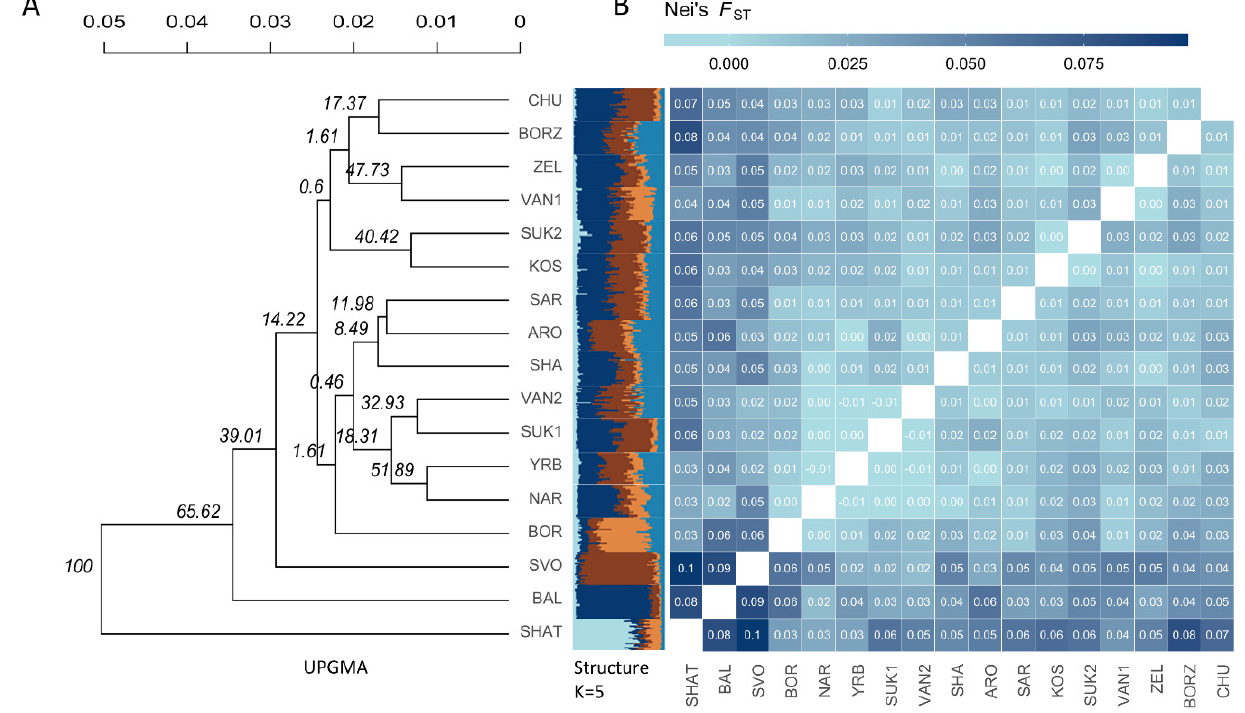
Figure 3. Bootstrapped UPGMA dendrogram ( A ), cluster assignments at K = 5, and the heatmap of pairwise of F ST between the 17 Scots pine populations investigated ( B ). Acronyms are as in Table 1.